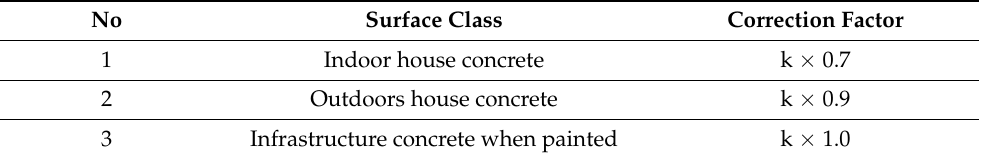
Table 7. Correction factors for surface treatment.